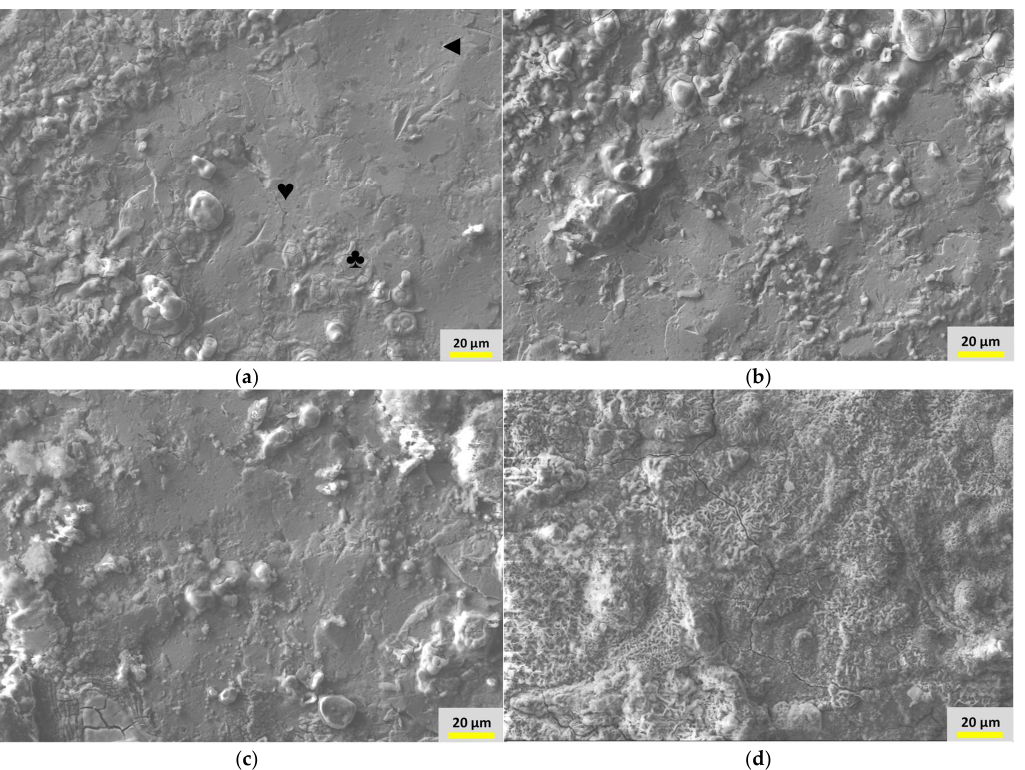
Figure 12. SEM photographs of carbon steel samples in position P1 at 32 days ( a ), 74 days ( b ), 120 days ( c ), and 241 days ( d ) of exposure.